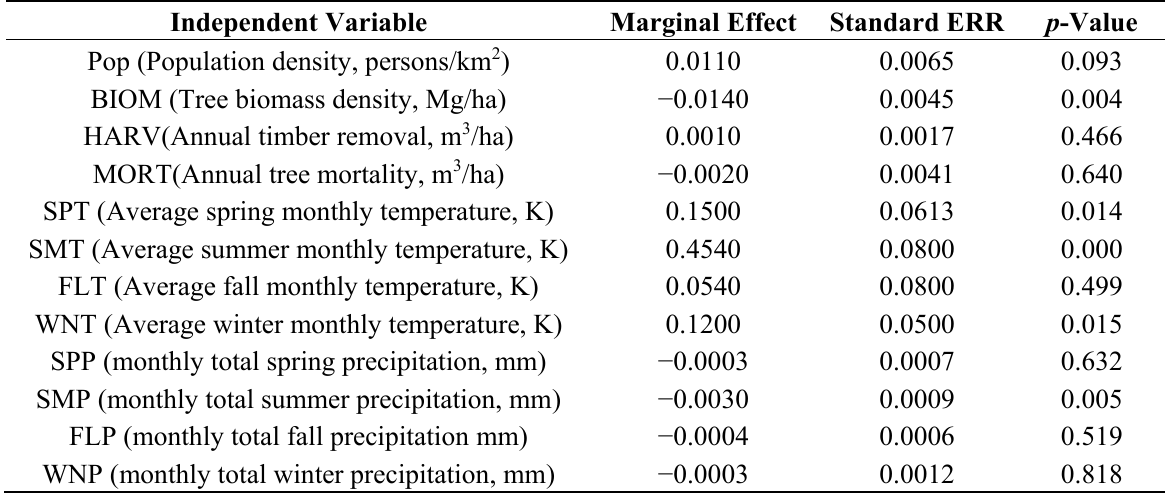
Table 2. Marginal effect of various factors on wildfire risk in the continental